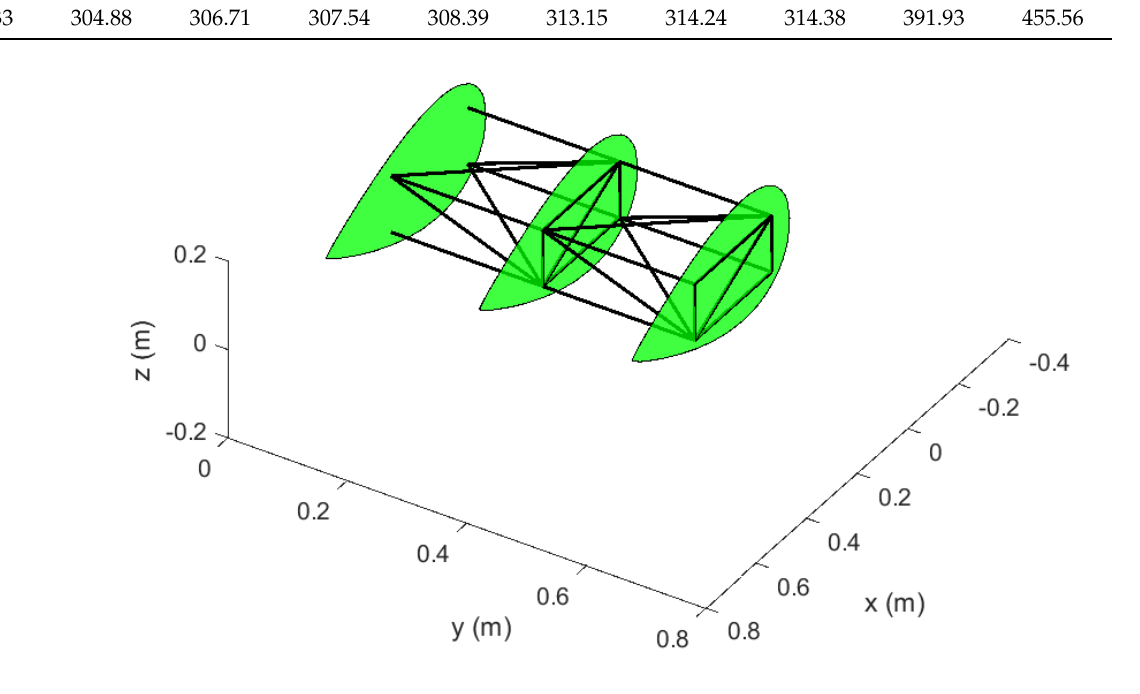
Figure 7. Undeformed wing with hinged ends in original (un–morphed) configuration (benchmark